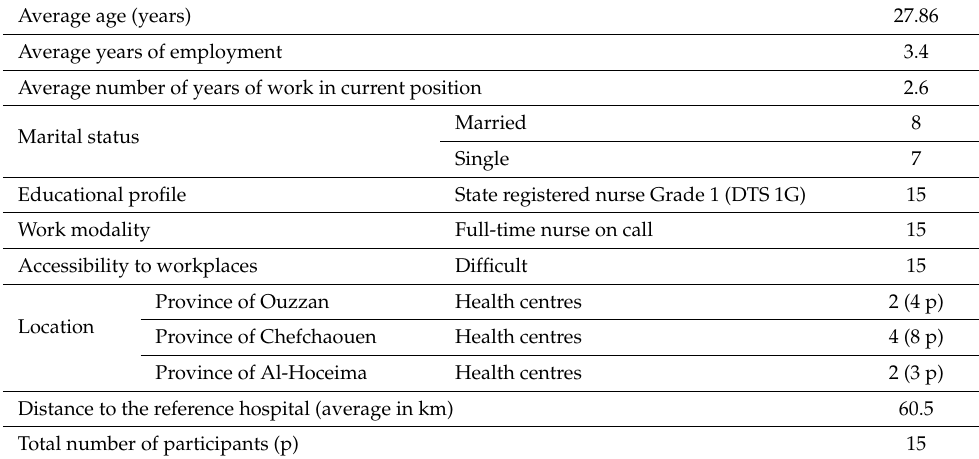
Table 1. Overview of the sociodemographic characteristics of the sample (n = 15).